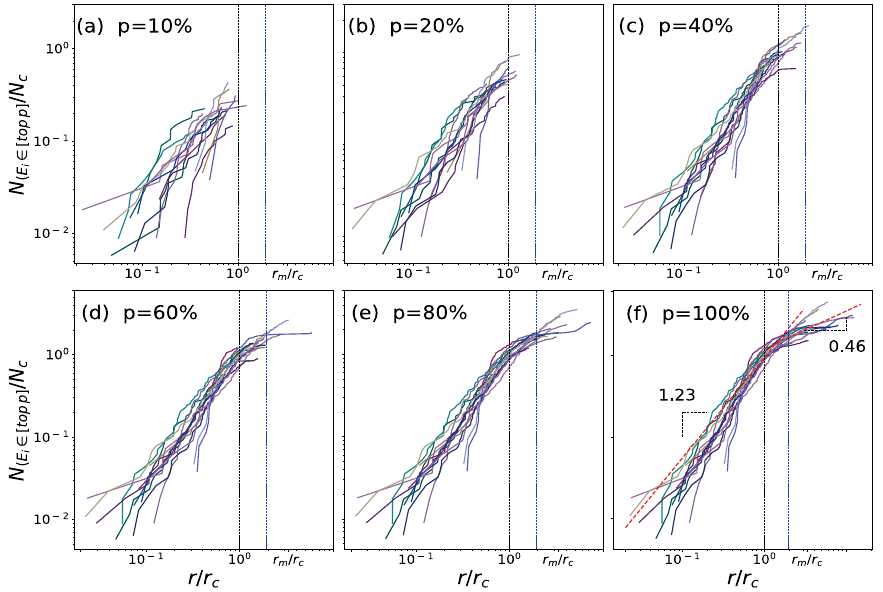
Figure 6. Highly efficient nodes in space. ( a ) For t = 2019 ( t e ), the top 10% highest efficient nodes in a disk of radius r as a function of the rescaled variable r / r c . ( b ) Same as ( a ) but showing the top 20%. ( c ) and ( d ) represent the top 40% and 60%, respectively. ( e ), and ( f ) represent the top 80% and all nodes (The dashed lines serve here as a guide to the eye). The physical distances are originated from the center of the core defined in